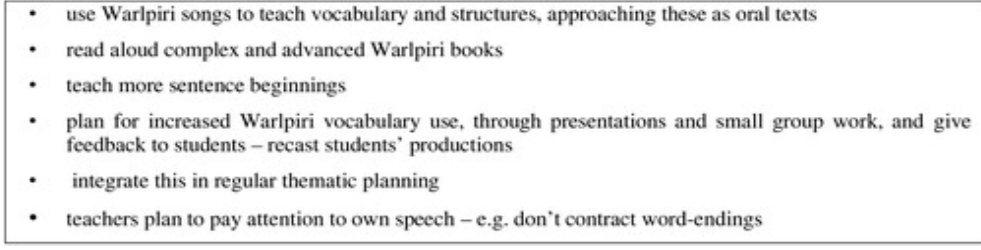
Table A1. Transcription conventions adapted from (Jefferson